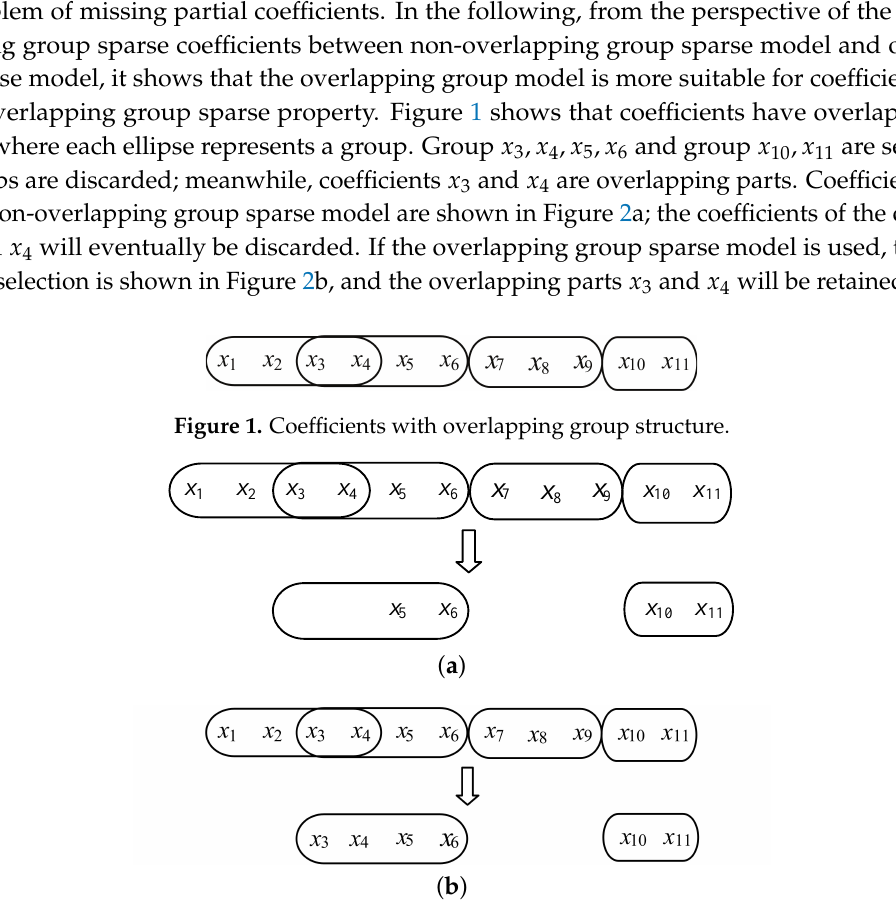
Figure 2. Coefficient selection results: ( a ) non-overlapping group sparse; ( b ) overlapping group